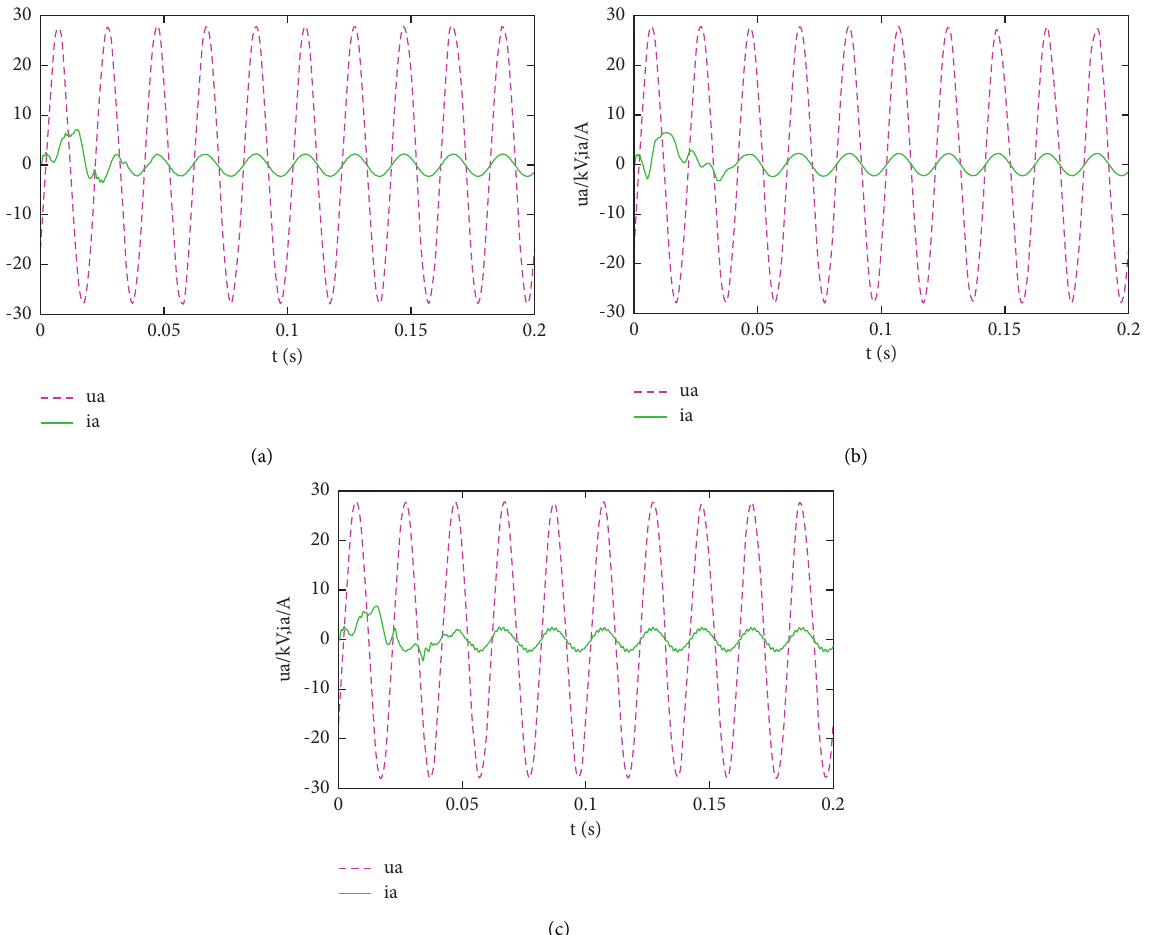
Figure 7: u i a and a response curves. (a) (c) u a and i a response curves of the PID